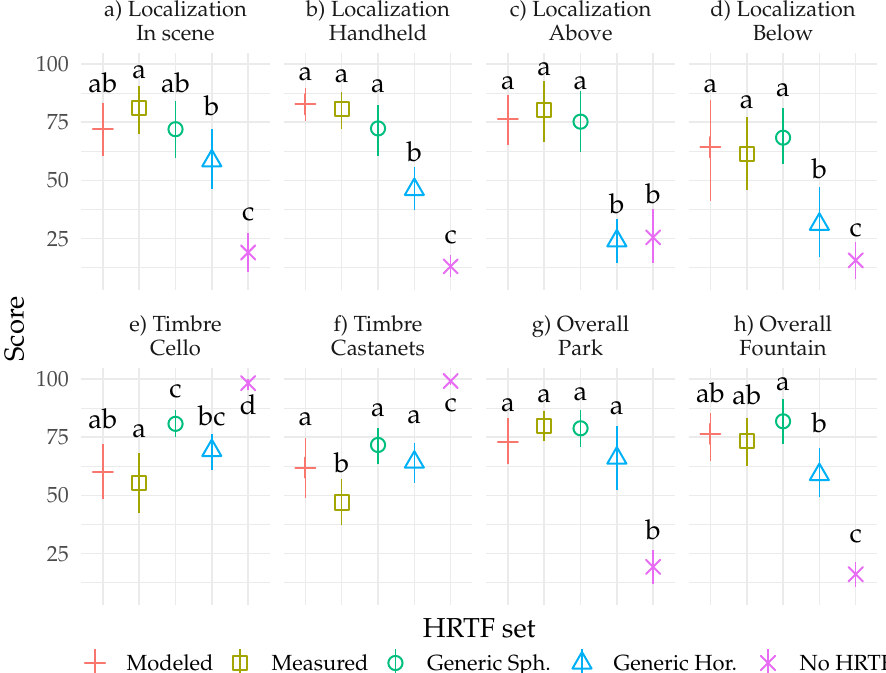
Figure 5. Subjective scores from the 6-DoF VR experiment. Panels ( a – d ) display results from the localization scenes, panels ( e , f ) timbre scenes, and panels ( g , h ) overall quality scenes. The error bars denote the bootstrapped 95% confidence intervals of the mean and the letters denote the significant differences ( p ≤ 0.05) between conditions calculated by pairwise permutation tests. Conditions with the same letter are not significantly different from each